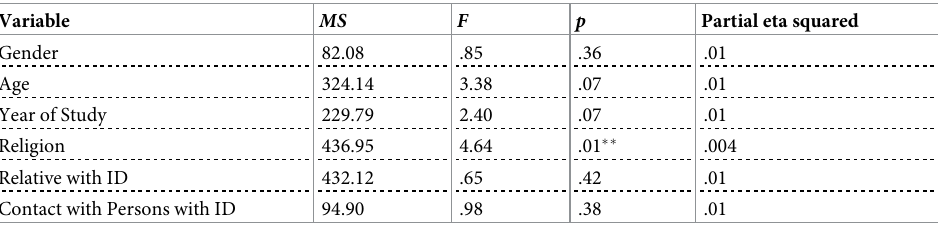
Table 5. Summary of two-way analysis of